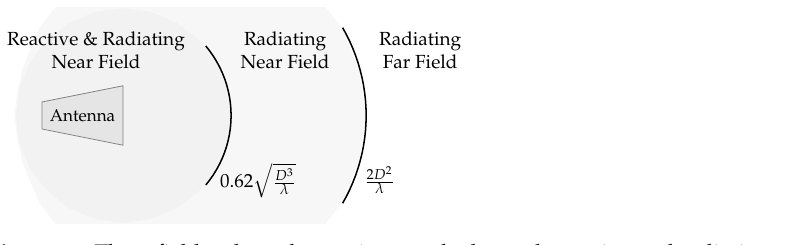
Figure 19. Three fields where the receiver can be located: reactive and radiating near field, radiating near, and far field. Distances depend on wavelength λ and antenna dimension